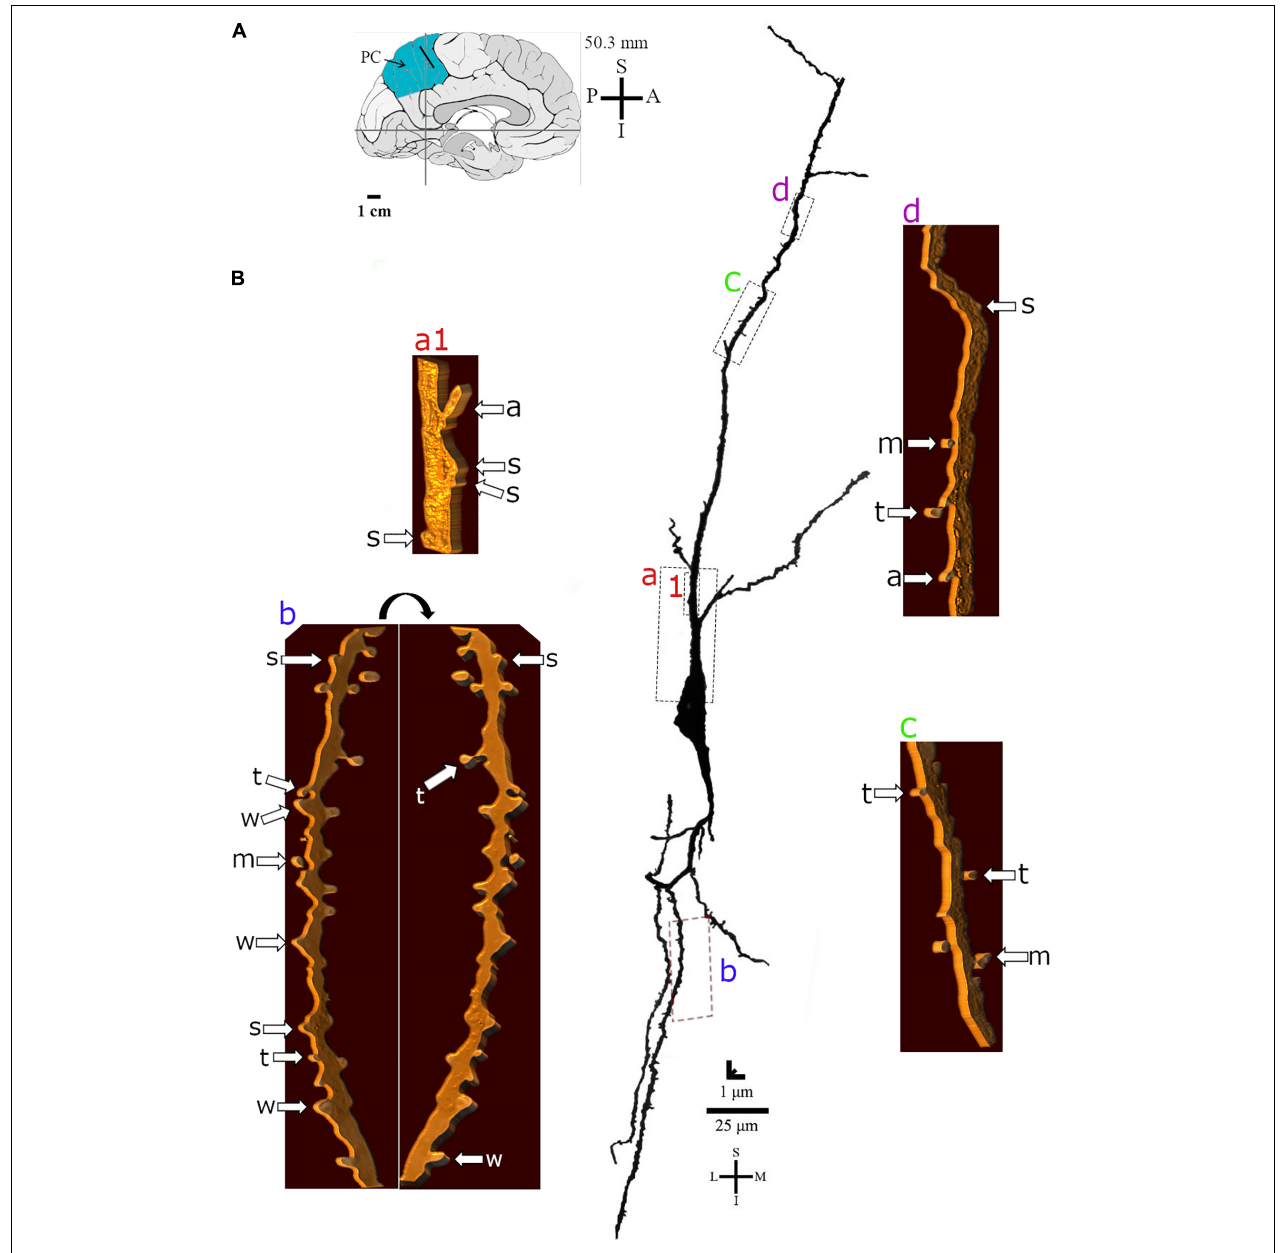
FIGURE 6 | (A) Left: Schematic drawing of the medial view of the human brain showing the location of the precuneus (PC, highlighted in blue), anterior region, 50.3 mm posterior to the midpoint of the anterior commissure. Adapted from Mai et al. (2008, 2016). (B) Two-dimensional (for the overall shape) and 3D (for the dendritic and spine details) image reconstructions of serial brightfield photomicrographs of a Golgi-impregnated spindle-shaped neuron from layer V in the human PC (pial surface at the top). Note the cell body shape, the main ascending and descending primary dendrites with a straight course and ramifications. Proximal to distal dendritic segments (identified by colored letters from “a” to “d”) were sampled and their spines are shown at higher magnification in the adjacent corresponding boxes. Note the sparse distribution and density of spines. Spines were classified as stubby (s), wide (w), thin (t), mushroom (m), with a transitional (t), or atypical aspect (a). Spine types are indicated at different rotating angles. Image adjustment of contrast made with Photoshop CS3 (Adobe Systems, Inc., United States). Coordinates in (A,B) : I, inferior; L, lateral; M, medial; S, superior. Scale = 25 µ m for the 2D reconstruction and 1 µ m for the 3D